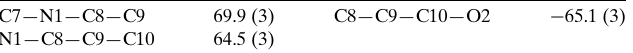
Table 1 Selected torsion angles ( (cid:3) ).